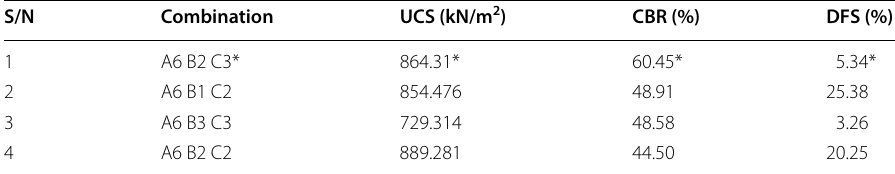
* Represents the optimal combination